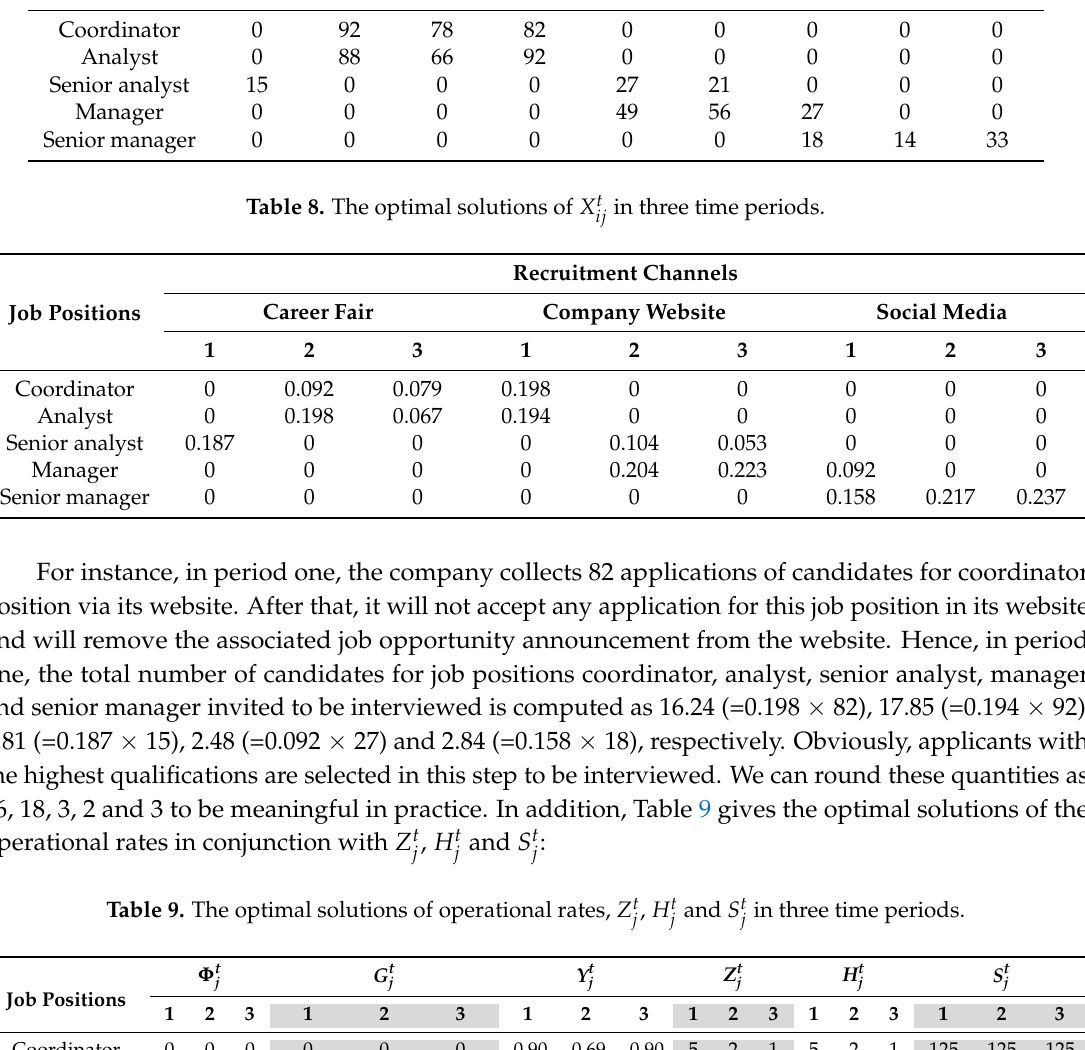
Table 9. The optimal solutions of operational rates, Z t